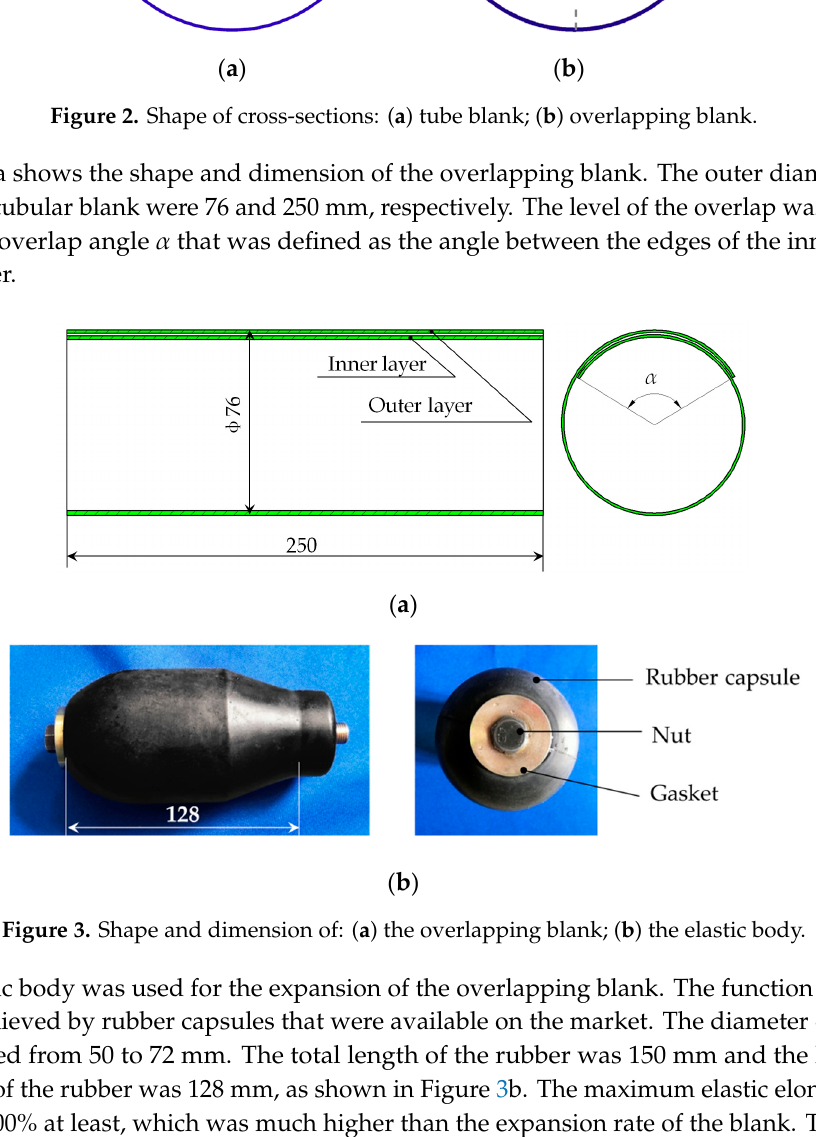
Figure 3. Shape and dimension of: ( a ) the overlapping blank; ( b ) the elastic body.